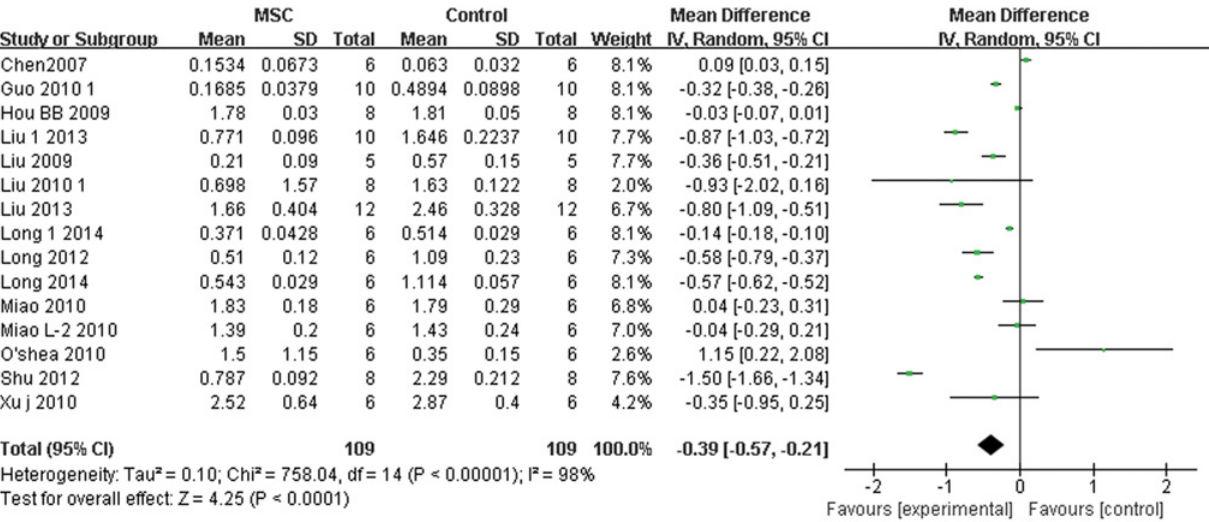
Fig. 3 shows the results of the subgroup analyses. In studies with low MSC doses ( (cid:1) 10 6 ), the I/M (95% CI, -0.15 – 0.26) was 0.05 lower in the MSC group versus the control group. In studies with high MSC doses ( > 10 6 ), the I/M was significantly lower (mean difference, 0.57; 95% CI, 0.33 – 0.81; P < 0.001). The sub-analyses also demonstrated that the I/M measured at 14 days ( < 28 days) was 0.02 (95% CI, -0.18 – 0.22) lower in the MSC group compared with the control group, while the I/M measured at (cid:3) 28 days was significantly lower, by 0.55 (95% CI, 0.31 – 0.80; P < 0.001). The studies that used an intravenous injection route showed a 0.39 lower I/M in the MSC group compared with the control group (95% CI, 0.17 – 0.61; P < 0.001), while the arterial injection route resulted in a 0.37 (95% CI, 0.07 – 0.67; P < 0.001) lower I/M. After carotid balloon